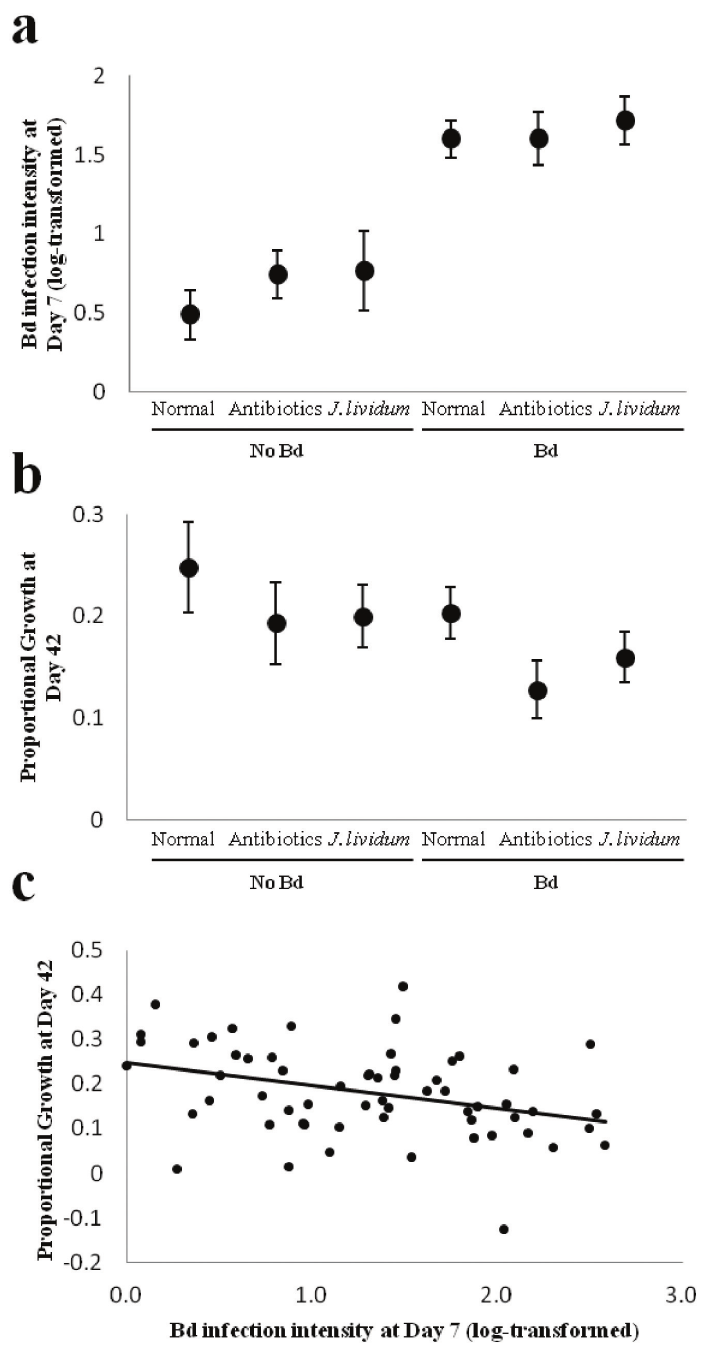
Fig 2. Effects of treatment on bullfrogs ’ Bd infection intensity at day 7 (a) and proportional growth at day 42 (b). Error bars represent standard error. The significant relationship between individual bullfrogs ’ Bd infection intensity at day 7 and proportional growth at day 42, the end of the experiment